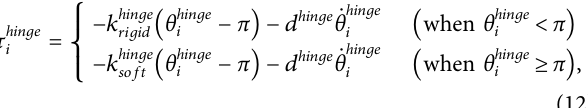
Supplementary Movie 5 | Simulated walking on irregular terrain with